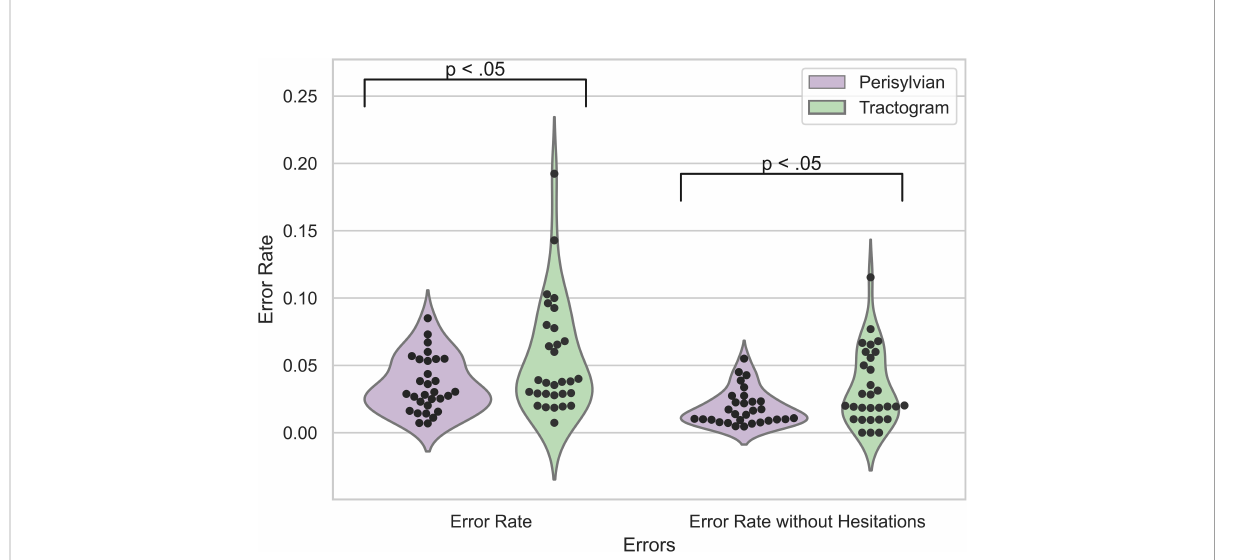
FIGURE 2 ERs of nTMS results for the perisylvian (purple) and tractogram-based (green) protocol. ER, error rate: the sum of nTMS errors divided by the total number of stimulations. The violin plot shows overall ERs as well as ERs without hesitation errors. The black dots represent the individual data points per